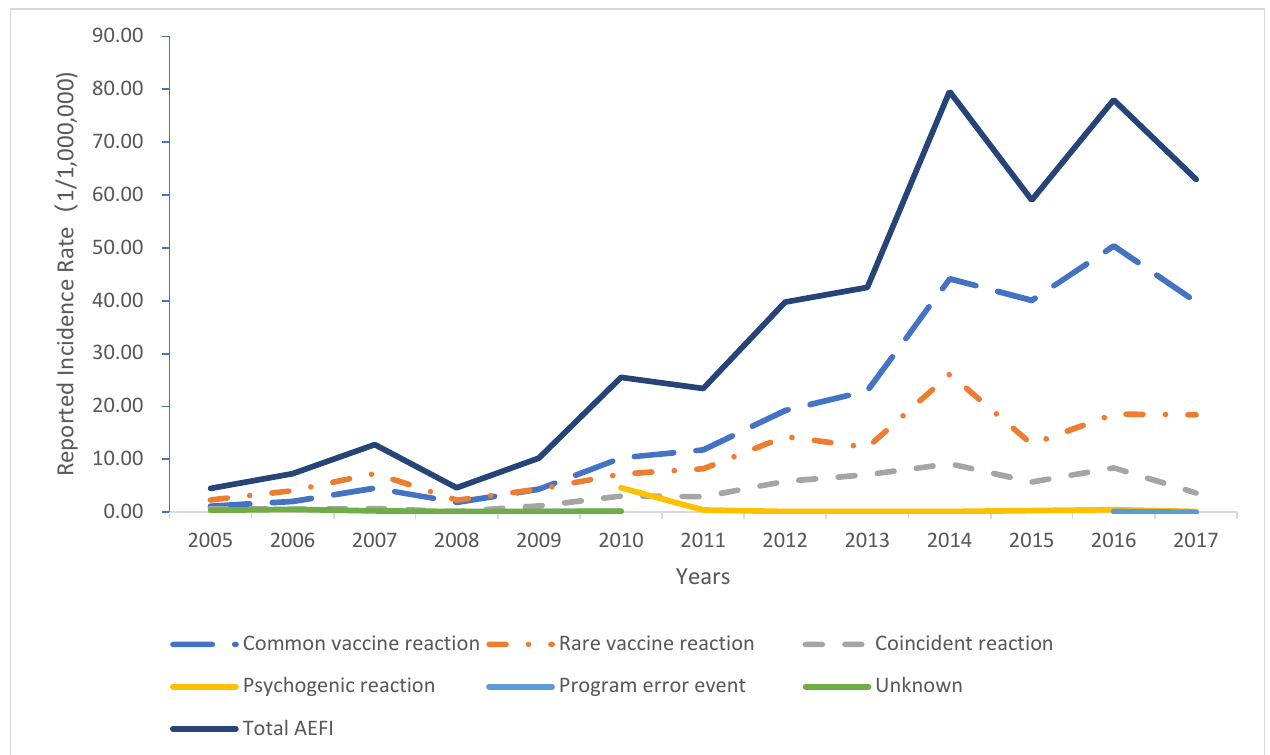
Figure 1. The incidence of adverse events related to HBV vaccination in Guangdong Province from 2005 to 2017 (1/1,000,000). Table 2. The adverse events related to HBV vaccination in Guangdong Province from 2005 to 2017 by gender and age.